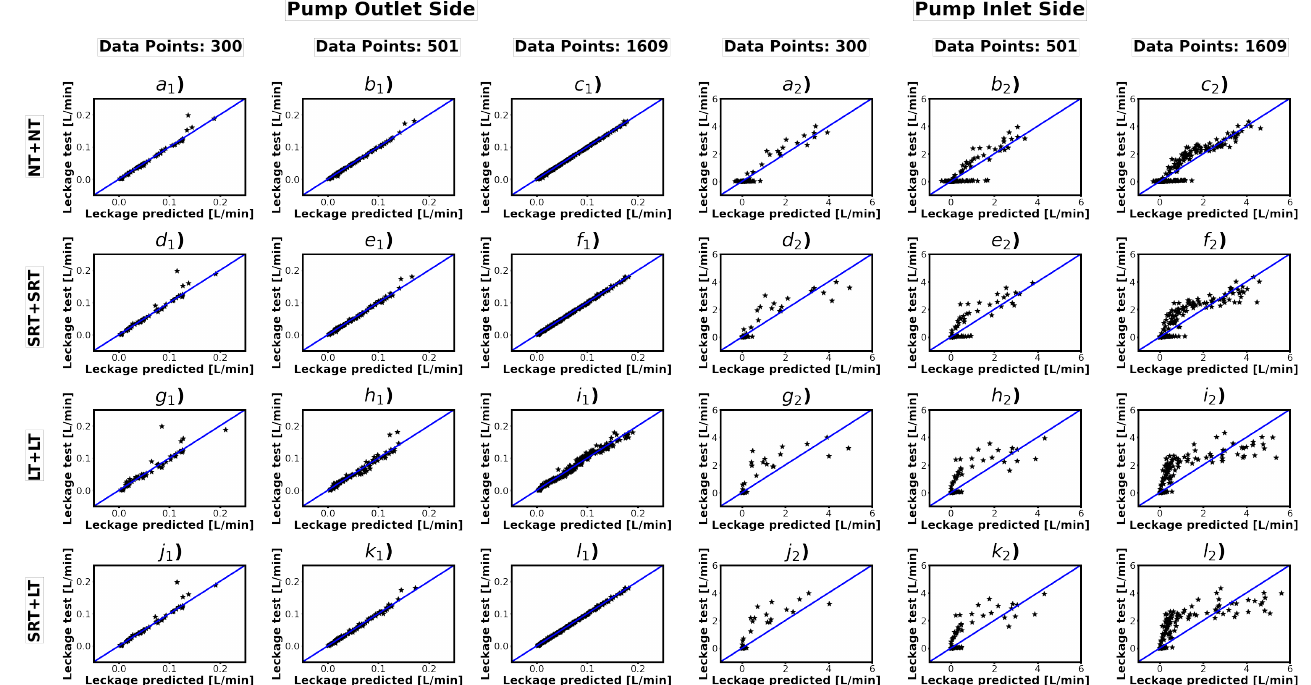
Figure 8. Support Vector Regression Test Results Visualization. ( a 1 , 2 ) Model: 300 data points without transformation on both sides of the pump. ( b 1 , 2 ) Model: 501 data points without transformation on both sides of the pump. ( c 1 , 2 ) Model: 1609 data points without transformation on both sides of the pump. ( d 1 , 2 ) Model: 300 data points using SRT on both sides of the pump. ( e 1 , 2 ) Model: 501 data point susing SRT on both sides of the pump. ( f 1 , 2 ) Model: 1609 data points using SRT on both sides of the pump. ( g 1 , 2 ) Model: 300 data points using LT on both sides of the pump. ( h 1 , 2 ) Model: 501 data point susing LT on both sides of the pump. ( i 1 , 2 ) Model: 1609 data points using LT on both sides of the pump. ( j 1 , 2 ) Model: 300 data points using SRT on data of pump’s outlet side and LT on data of pump’s inlet side. ( k 1 , 2 ) Model: 501 data points using SRT on data of pump’s outlet side and LT on data of pump’s inlet side. ( l 1 , 2 ) Model: 1609 data points using SRT on data of pump’s outlet side and LT on data of pump’s inlet